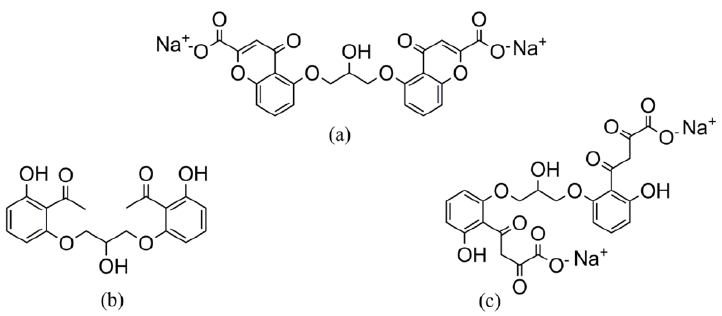
Figure 1. Chemical structures of ( a ) CS, ( b ) Deg1 and ( c ) Deg2.